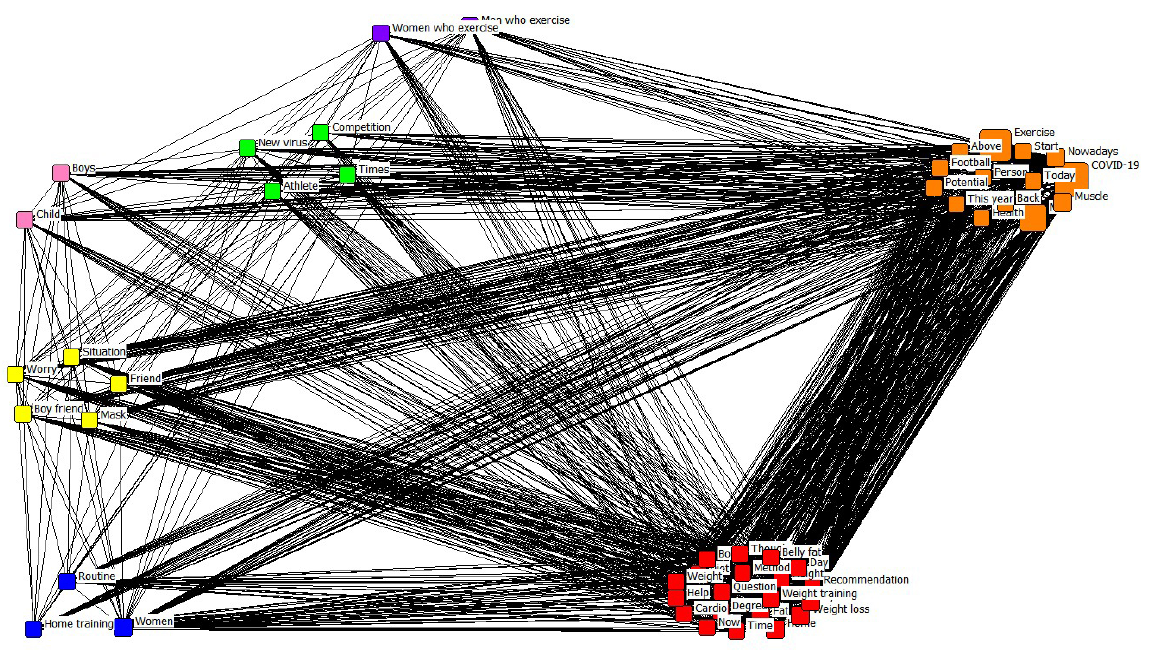
Fig. 2. Men’s exercise CONCOR analysis results. Red cluster = exercise method; orange cluster = COVID-19 situation; yellow cluster = friends; green cluster = sports; blue cluster = women’s fitness; pink cluster = children; violet cluster =